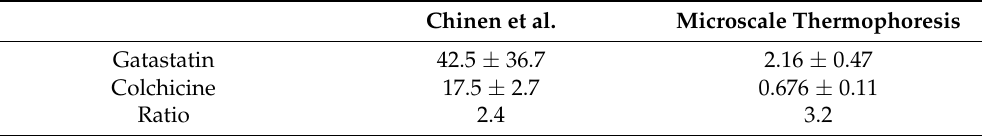
Table 8. Comparison of experimentally derived and computationally predicted K d values ( µ M) for gatastatin and colchicine binding to α - β